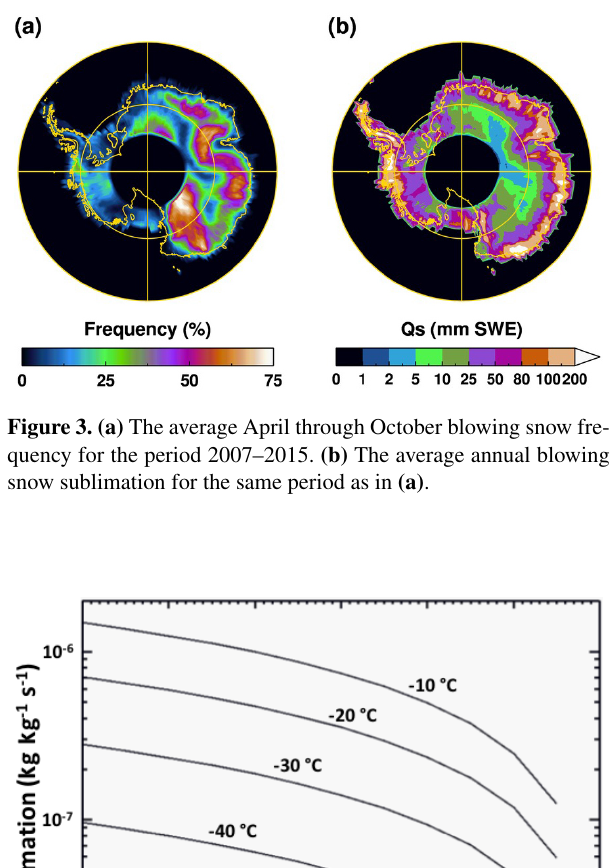
where q b (z) is the blowing snow mixing ratio from Eq. (4), u(z) is the MERRA-2 wind speed at height z and Q t has units of kg m − 1 s − 1 . The wind speed is linearly interpolated from the nearest two model levels. As with the sublimation, these values are gridded and normalized by the total number of observations. The transport values are computed for each month of the year by summing daily values and then multi- plying by the number of seconds in the month (resulting units of kg m − 1 ) . The monthly values are then summed to obtain a yearly amount. A further conversion is performed to produce units of Gt m − 1 yr − 1 by dividing by 10 12 (1000 kg per metric ton and 10 9 tons per